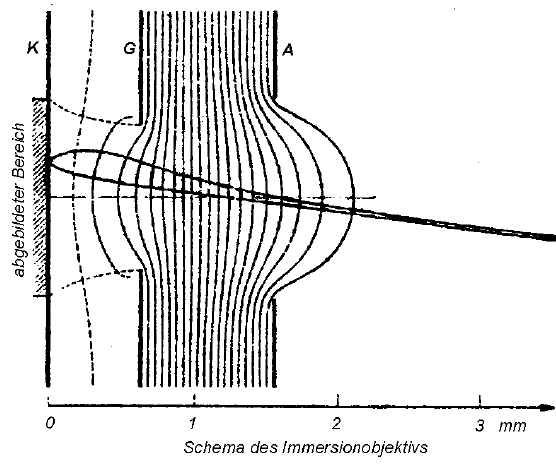
Figure 1. Scheme of the immersion objective lens reproduced from [2], in which the figure has been adapted according to the original in